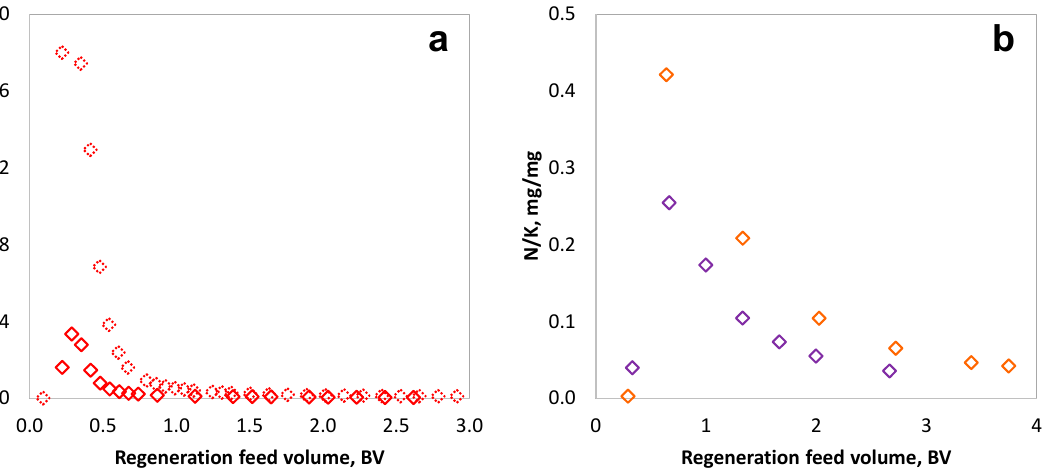
Figure 6. N/K ratio in the byproduct: ( a ) the data from regeneration experiments when 1 mol/L and 2 mol/L K 3 PO 4 were both tested, ( b ) data based on 2 mol/L K 3 PO 4 regeneration from laboratory cyclic tests cycle 7 with 12 BV loading and pilot experiments cycle P7 with 7 BV loading). Red symbols: regeneration tests; yellow symbols: laboratory test cycle 7; purple symbols: pilot test cycle 7. Dash-line symbols: 1 mol/L K 3 PO 4 ; solid-line symbols: 2 mol/L K 3 PO 4 .